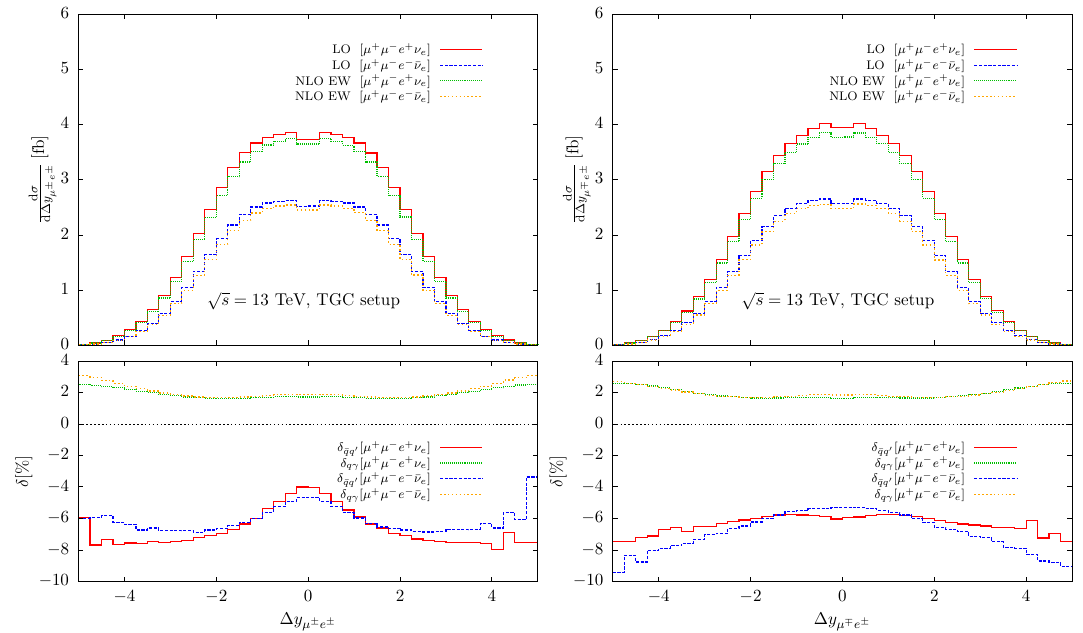
Figure 9 . Distribution in the rapidity difference of the µ ± e ± pairs (left panel) and the µ ∓ e ± pairs (right panel) for ZW + and ZW − in the TGC